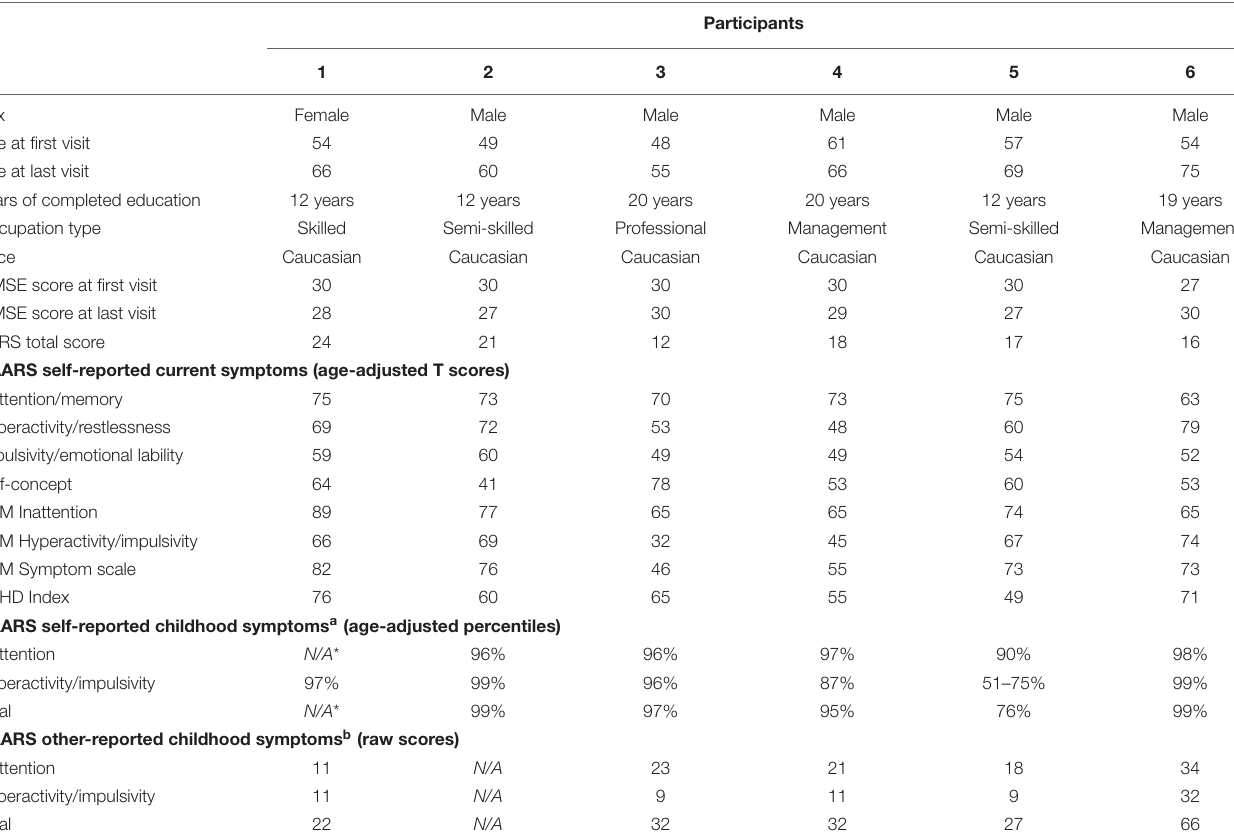
TABLE 1 | Demographic and clinical characteristics of the